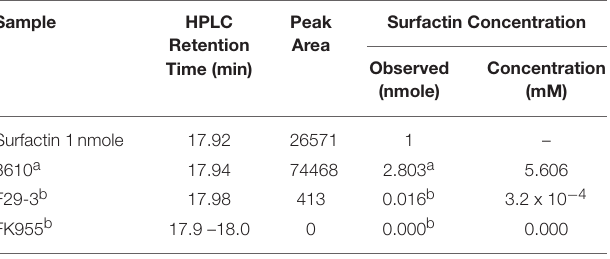
TABLE 3 | Surfactin expression of B. subtilis 3610, F29-3, and FK955.